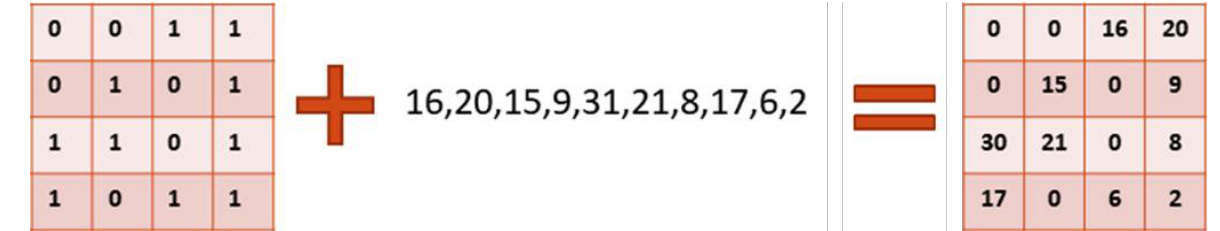
Figure 4. Bitmap-based magnetic field map compression method.